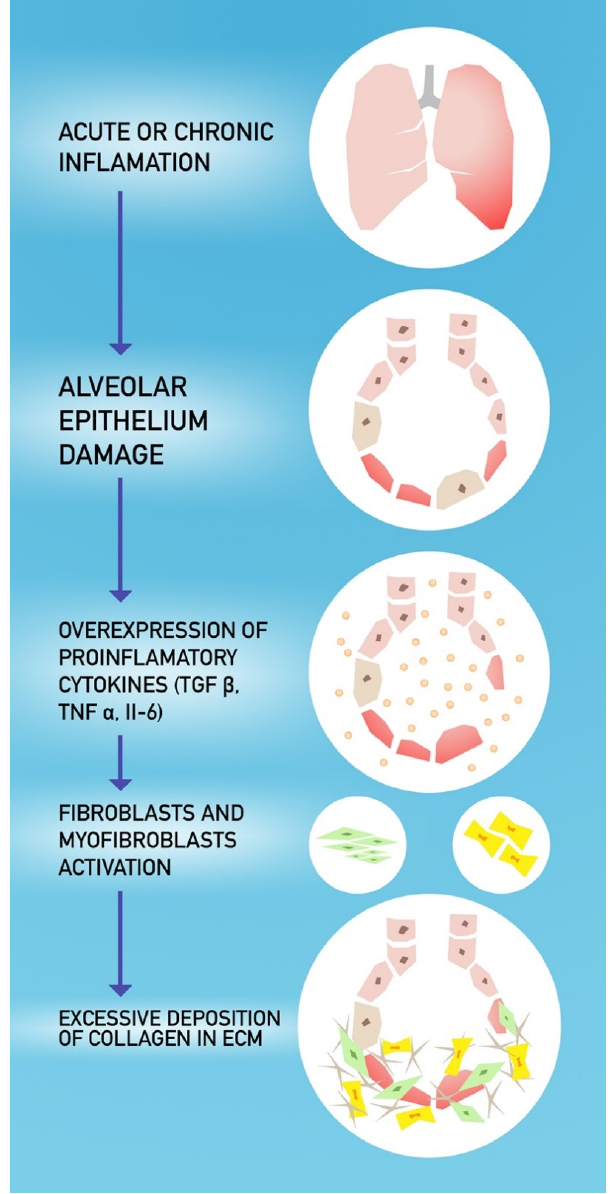
Figure 1. The pathogenesis of pulmonary fibrosis.